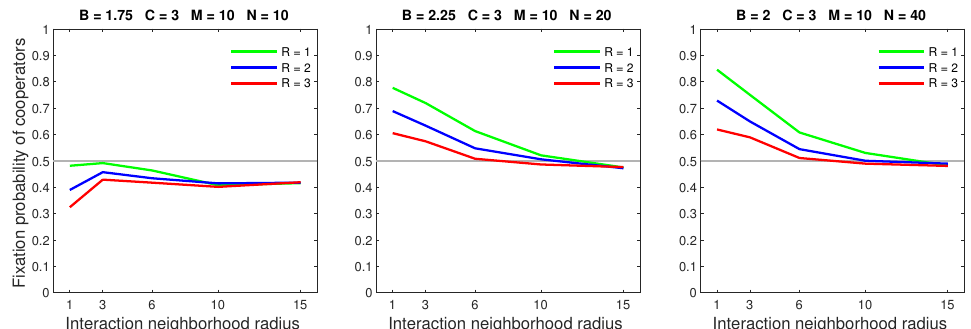
Figure 9. In the probabilistic dispersal model, increasing the dispersal range for a high mobility rate ( M = 10) causes a breakdown of cooperation in sparse populations and eliminates the advantage of cooperator in dense populations.